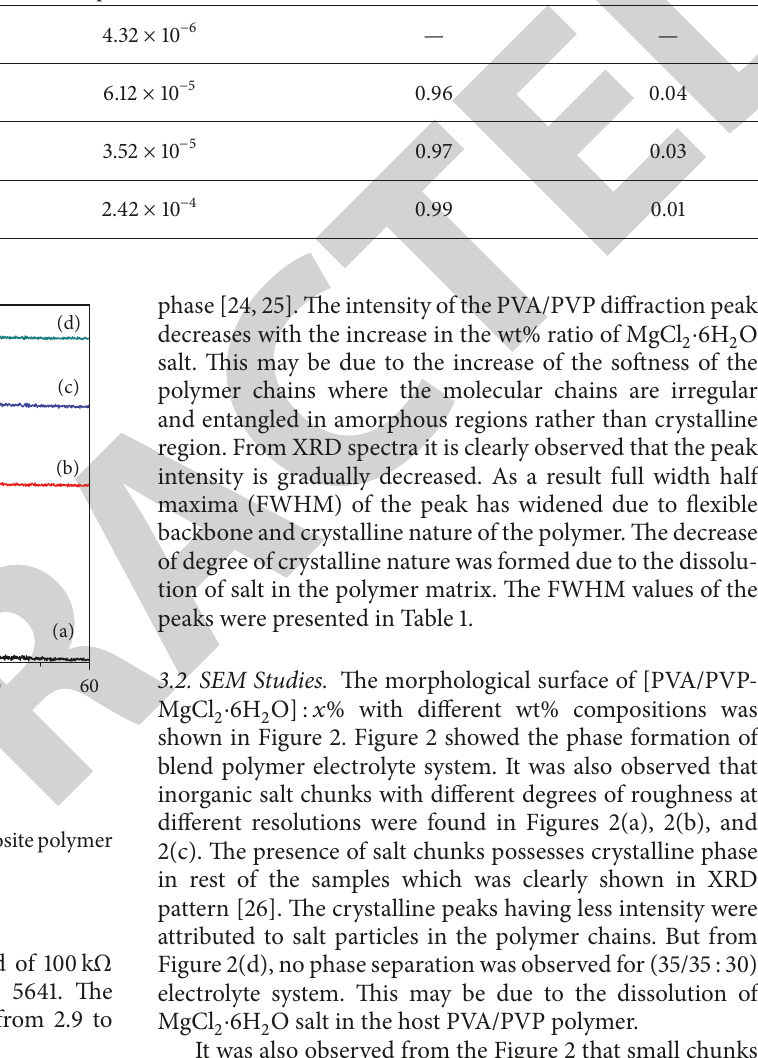
Blend polymer films